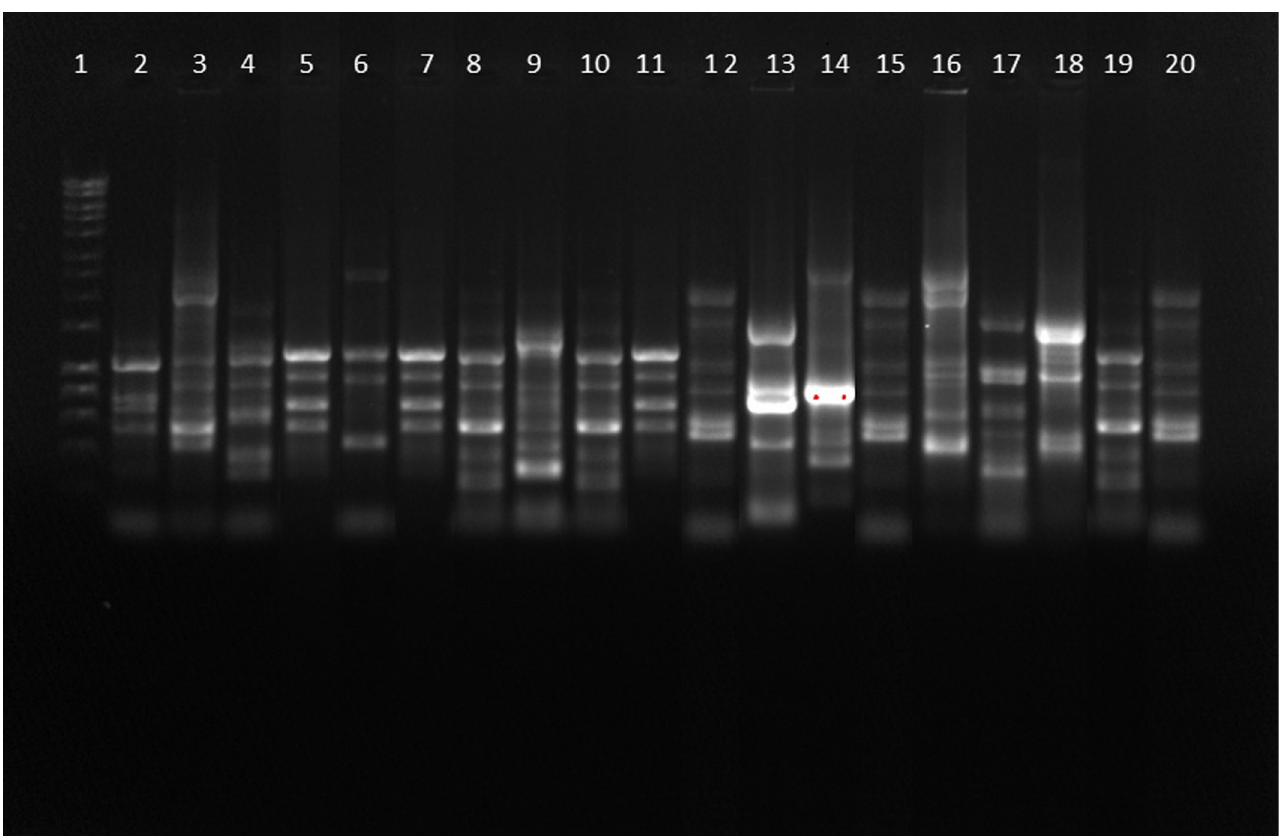
Fig 4. REP PCR showing different REP types of P . aeruginosa possessing increased efflux pump activity. Lane 1: Hyper ladder (1 kb); lane 2 to 20: test samples. 13 REP types can be seen in Lane 2, 3, 4, 5, 6, 8, 9, 12, 13, 14, 16, 17 and 18.